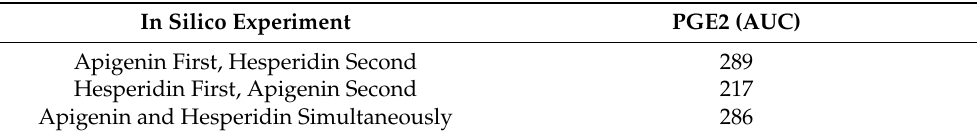
Table 2. PGE-2 estimations for additive effects of apigenin and